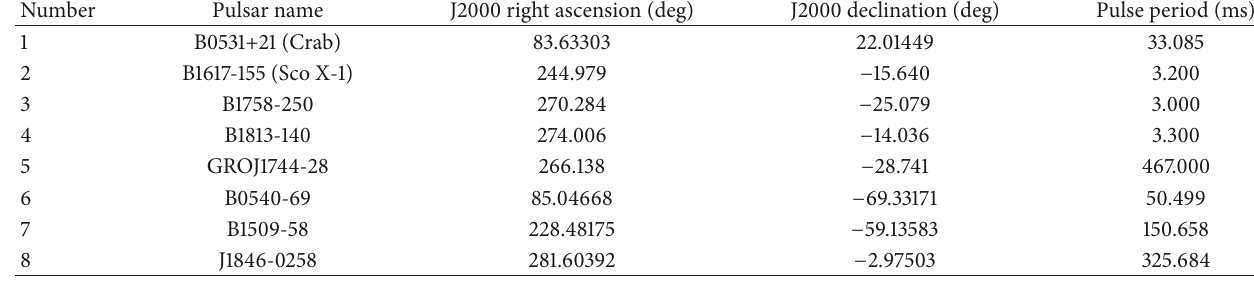
Table 1: Default targets’ angular positions and pulse periods.